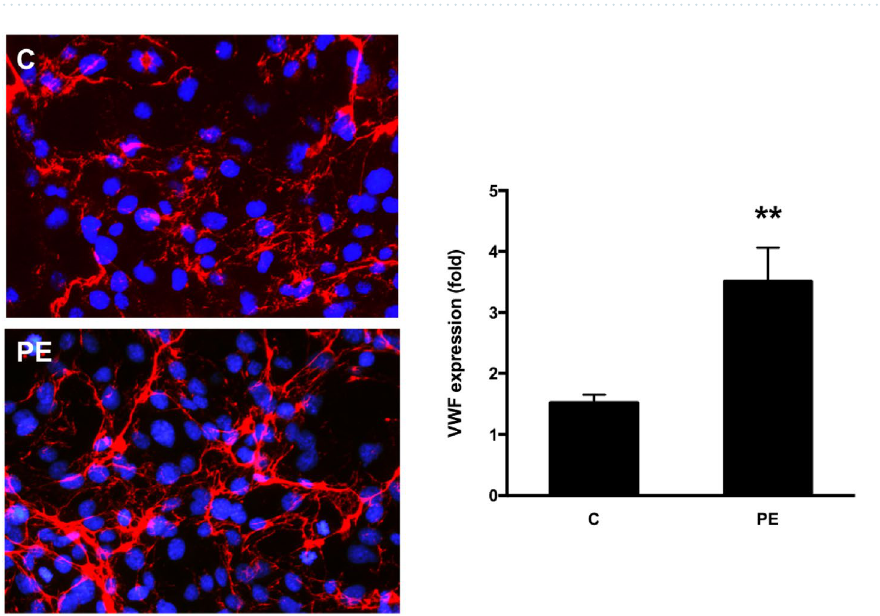
Figure 5. Representative microphotographs of the VWF deposits (red) on endothelial cells in vitro (blue- labeled nuclei) induced by incubation with plasma from healthy pregnancies and pregnancies complicated by preeclampsia. The bar chart represents the quantification of average VWF deposits. Whiskers represent the mean ± standard deviation. **p < 0.01 by Student’s t-test compared to